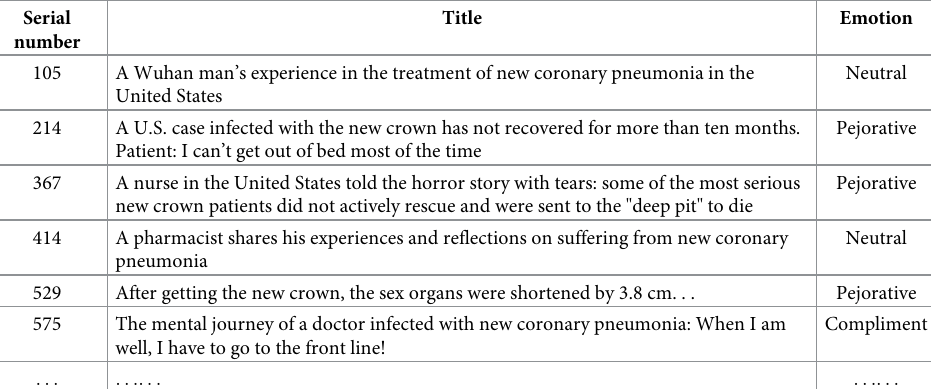
Table 6. Cases of user participation behaviors in "Lilac Forum" experienced during the pandemic.